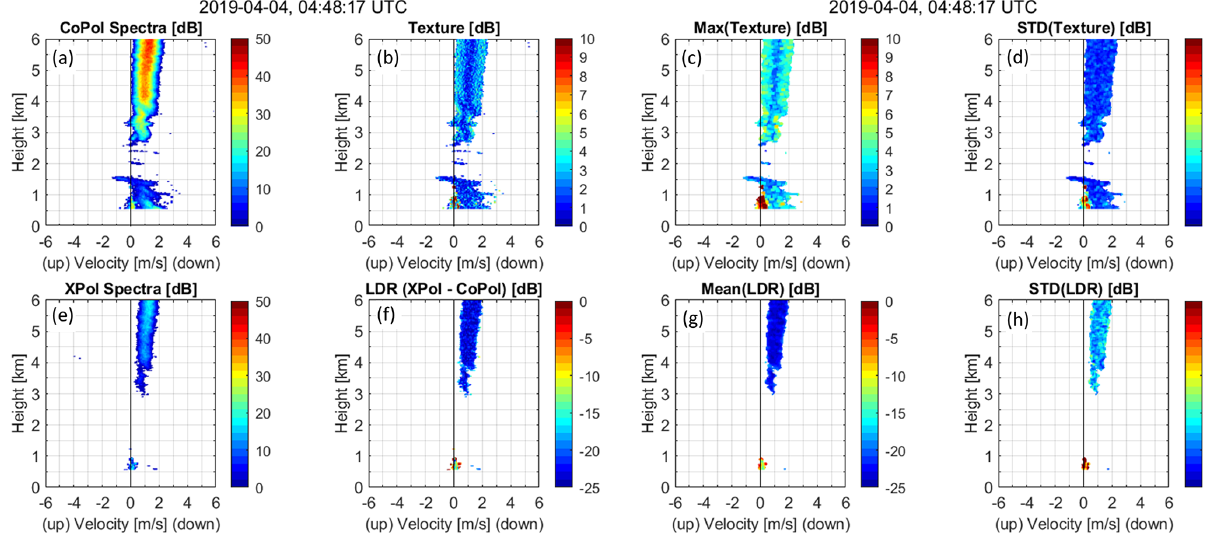
Figure 9. Same as Fig. 6 except for the profile at 04:48:17UTC on 4 April 2019.